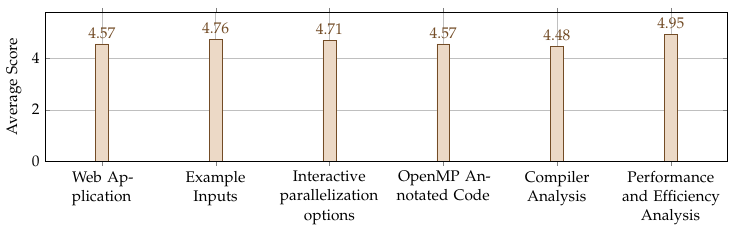
Figure 10. User feedback on existing iCetus